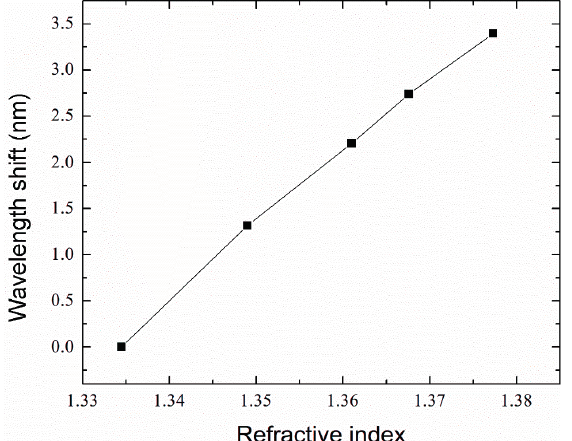
Figure 7. Wavelength shift as a function of refractive index